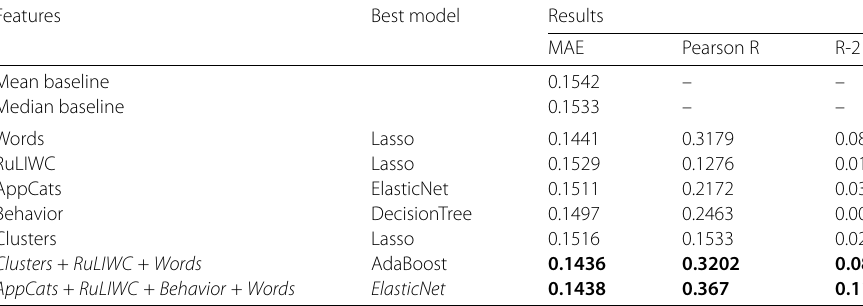
Table 8 WHO-5 value prediction